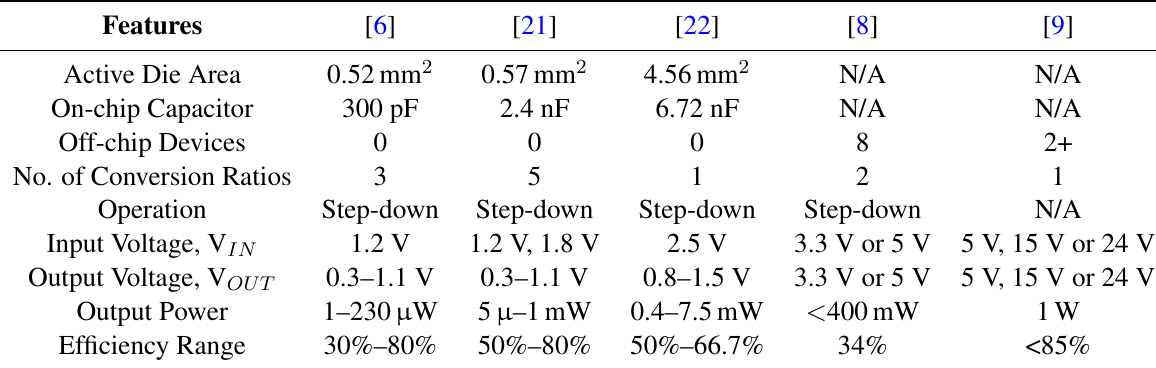
Table 1. Experimental/Research DC-DC Converters for Sensor